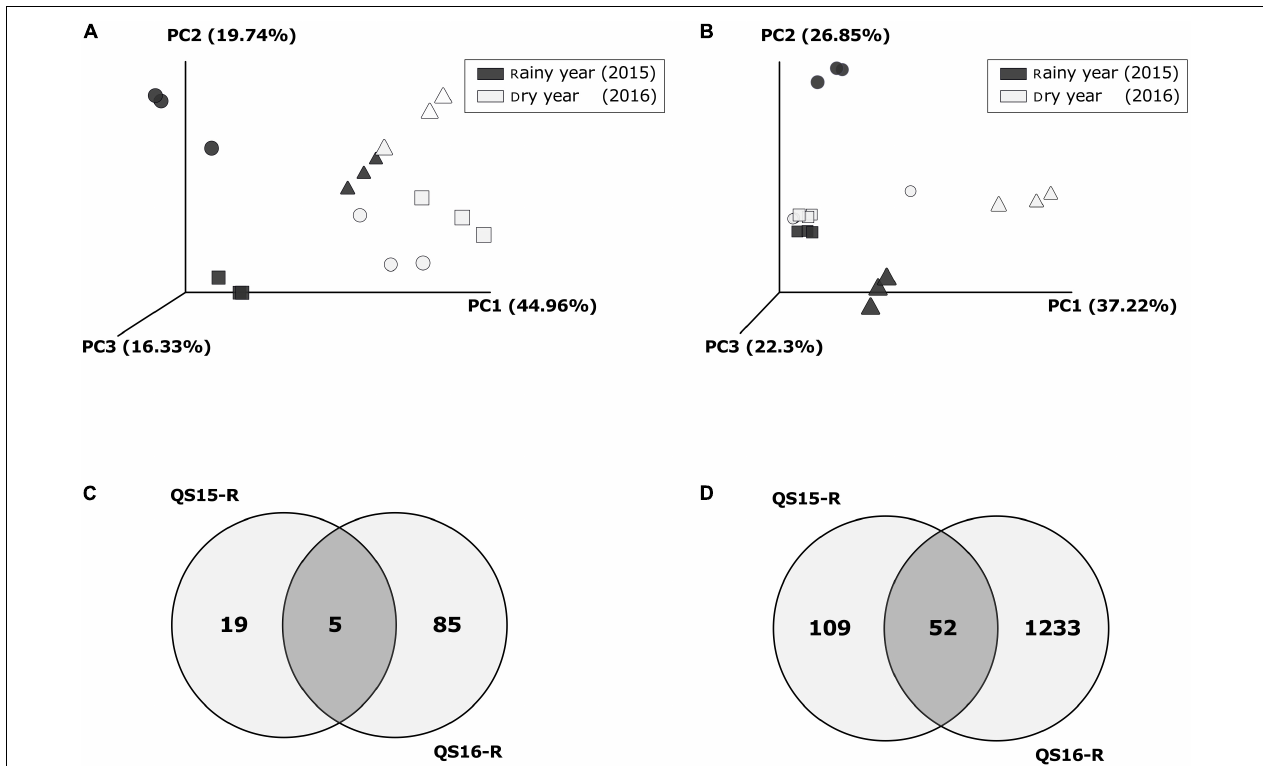
FIGURE 6 | Beta-diversity analysis and Venn diagrams: comparison between years at Quebrada Seca (QS). Principal Coordinates Analysis (PCoA) based on weighted UniFrac Distances per year and sample type, for fungi (A) and for prokaryotes (B) ; symbols represent sample types: Circles: Rhizosphere, Squares: Bulk soil, Triangles: Bare soil; (C) Venn diagram for rhizosphere specific fungal OTUs [fold change > 3 in case of rainy year (QS15-R); complete OTU table for rhizosphere dry year (QS16-R)]; (D) Venn diagram for rhizosphere specific prokaryotic OTUs (fold change > 3 in case of rainy year (QS15-R); complete OTU table for rhizosphere dry year QS16-R). Fold change > 3 is the rhizosphere OTUs divided by the sum of Bulk- and Bare-